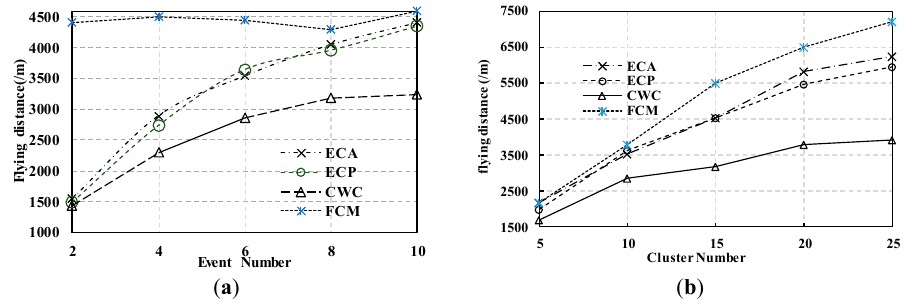
Table 1. The UAV and WSN parameters. Parameters